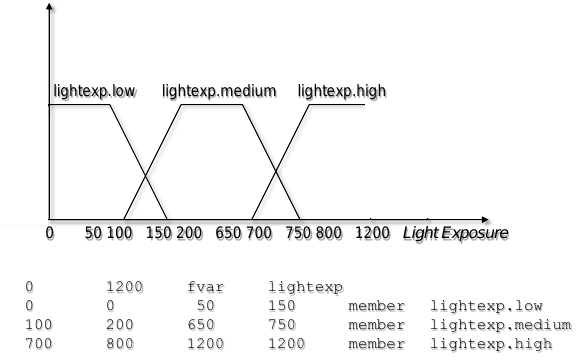
Figure 4. Fuzzy sets associated with the fuzzy variable lightexp . On the right side, the code to define the fuzzy variable lightexp and its membership functions. The definition domain, corresponding to the raw readings values interval [0,1200], is given before the word fvar , while the word member defines each of the three trapezoidal membership functions by using four control points (bottom-left, top-left, top-right, and bottom-right).